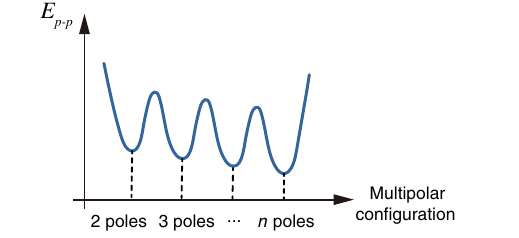
FIG. 11. Total pole-pole energy landscape of multiple poles.